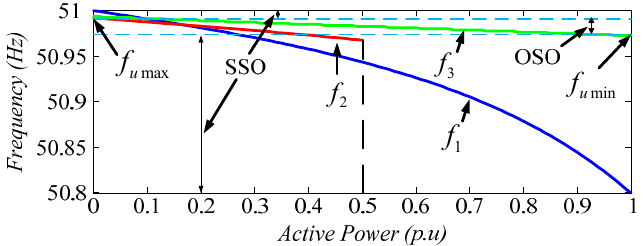
Figure 3. Proposed droop scheme without modifications for the considered AC MGs.